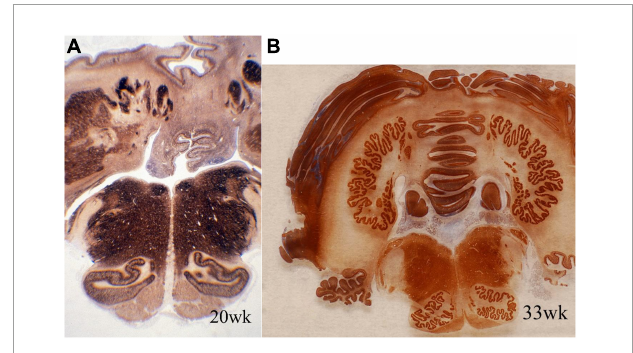
FIGURE3 Transverse sections of cerebellum and medulla oblongata of normal human fetuses of (A) 20 weeks and (B) 33 weeks gestation, showing synaptophysin immunoreactivity. The dentate nucleus and smaller deep cerebellar nuclei are amorphous in form at mid-gestation and exhibit the normal crenated adult form by 33 weeks gestation. Synaptogenesis already is evident before the mature morphology is achieved. The inferior olivary nuclei are a primitive C-shape at 20 weeks and are not crenated, but have the mature convoluted shape by 33 weeks. Synaptophysin is seen in the periphery of these nuclei but only weakly in the center at mid-gestation. Reproduced from reference (Sarnat et al., 2013a).